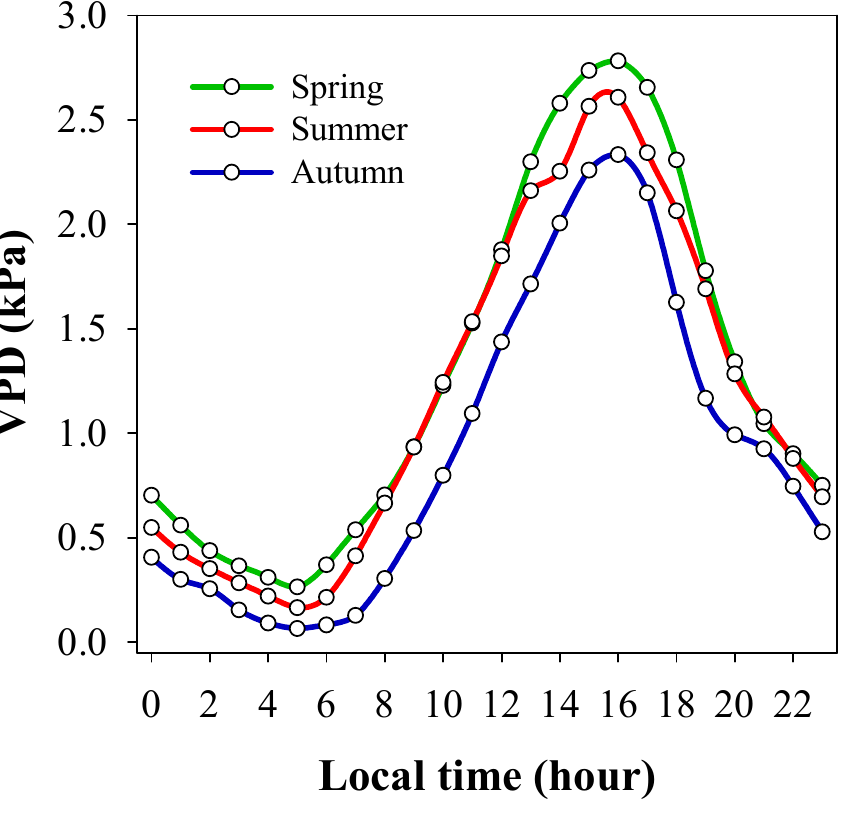
Figure 3. Diurnal variation of vapor pressure deficit (VPD) in the experimental location at the end of spring, midsummer, and the beginning of autumn.